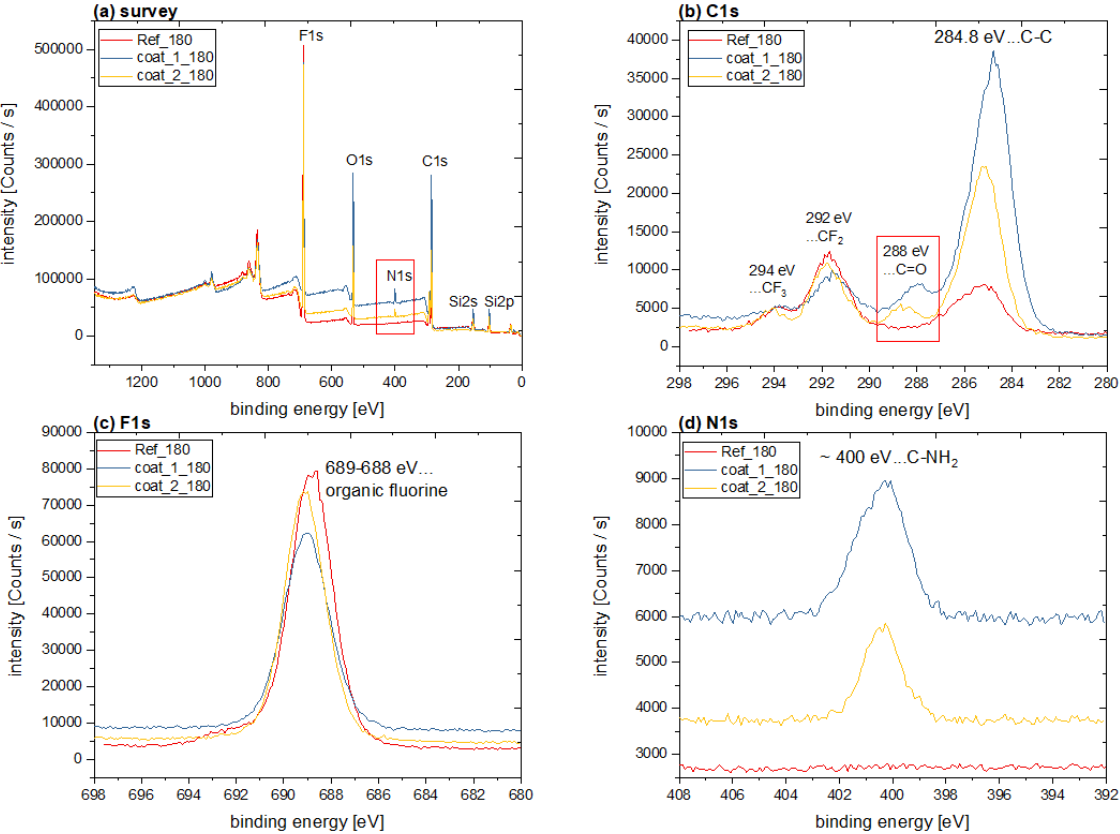
Figure 6. ( a ) XPS survey and ( b-d ) high-resolution spectra (C1s, F1s, N1s) of the reference and representative NIPTES-containing coatings.